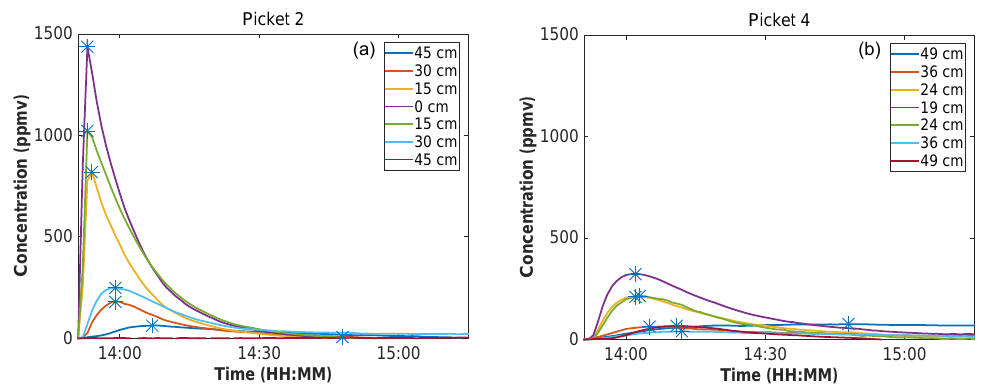
Figure 6. Calibrated near-field breakthrough curves for case 14 (a) and 19cm downstream of the release point (b) . CO concentration data were acquired at 1min resolution. The CO gas release position is on the opposite side of the picket from the mid-picket (0cm) sensor in panel (a) (see also Fig. 2). Distances given in the legend are measured from the release point to the given sensor for both figures. Blue asterisks demark time of maximum concentration at that